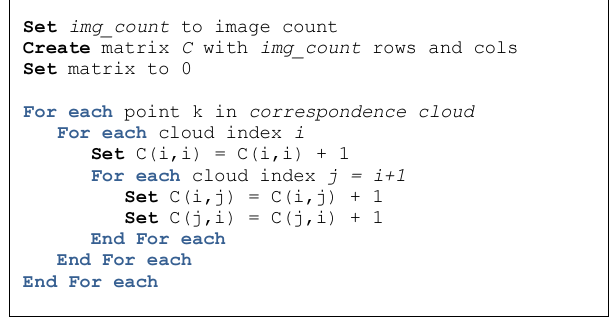
Table 1: Derivation of connectivity matrix from correspondence